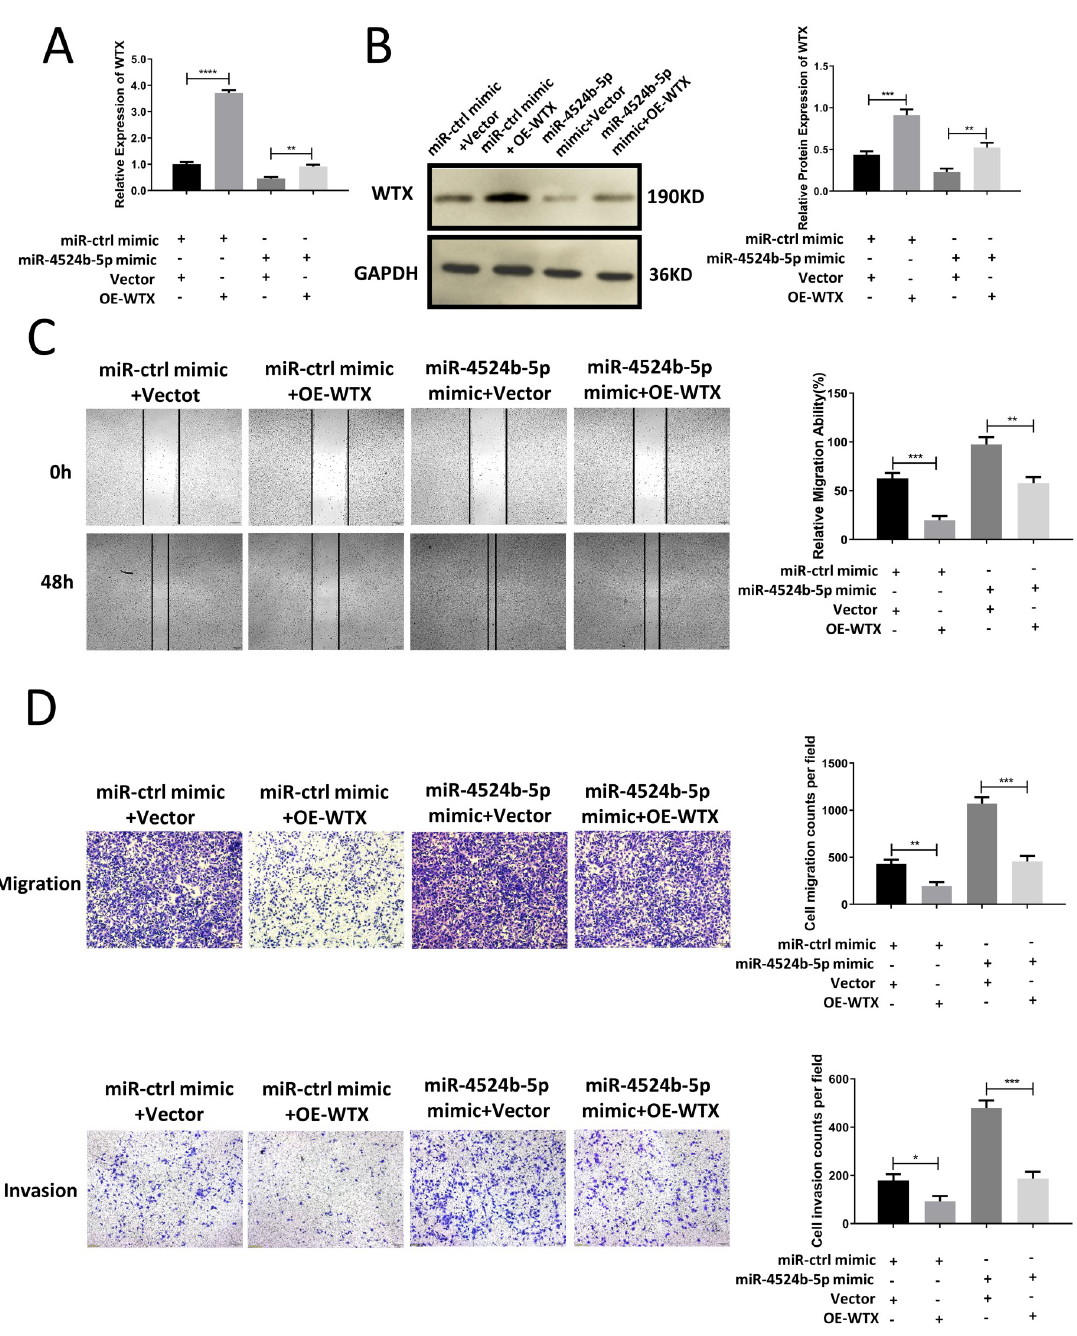
Fig 7. MiR-4524b-5p promoted cervical cancer cell migration and invasion by inhibiting WTX. (A) Cotransfection of the miR- 4524b-5p mimic and WTX overexpression plasmid into SiHa. qRT-PCR analysis of the mRNA expression levels of WTX. (B) Cotransfection of the miR-4524b-5p mimic and WTX overexpression plasmid into SiHa. Western blot analysis of the protein expression levels of WTX. (C) Cell migration was analyzed using a wound-healing assay. (D) Cell migration and invasion were analyzed by Transwell assay. All data are presented as the means ± SEM, �� P < 0.01, ��� P < 0.001, ���� P <